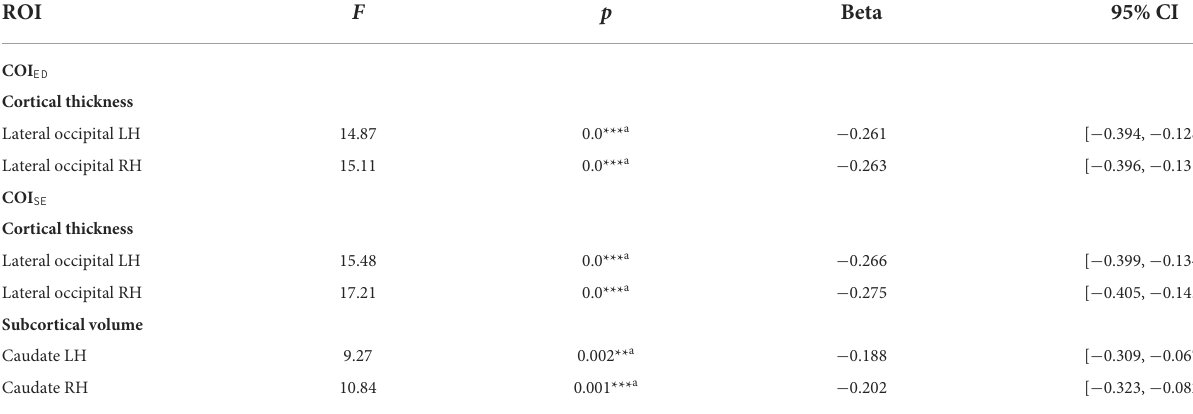
TABLE 3 Brain regions that showed three-way interactions with each domain of the child opportunity index (COI). ROI F p Beta 95% CI COI ED